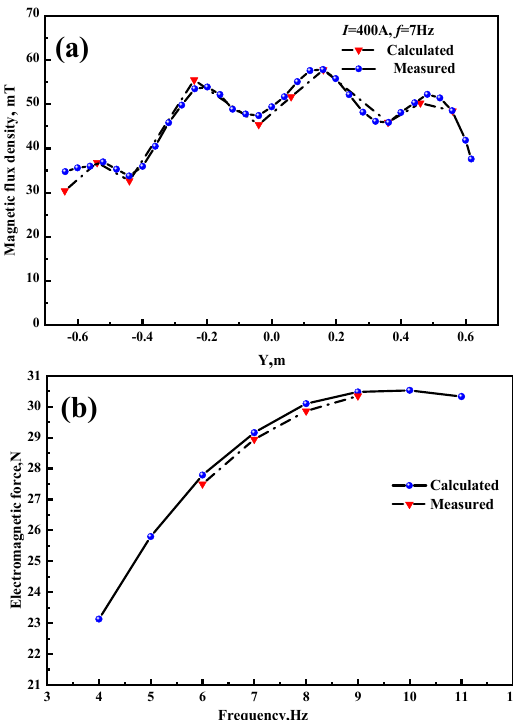
Figure 5. Comparison of measured and calculated values on the centerline of the wide face of the pair of rollers: ( a ) magnetic flux density, ( b ) electromagnetic